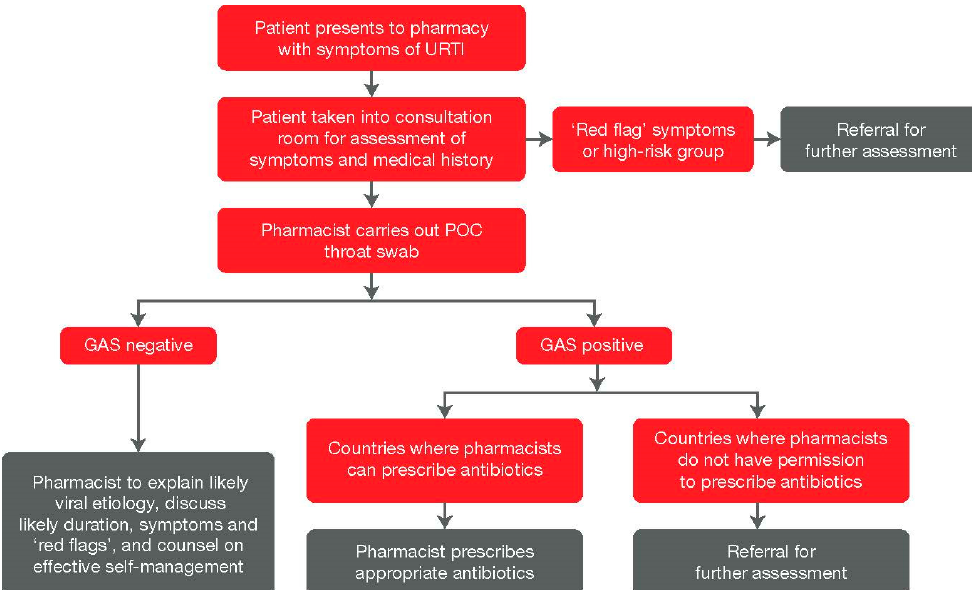
Figure 1. Proposed screening process and methodology for POC testing in the community pharmacy. GAS: group A Streptococcus; POC: point-of-care; URTI: upper-respiratory tract infection.